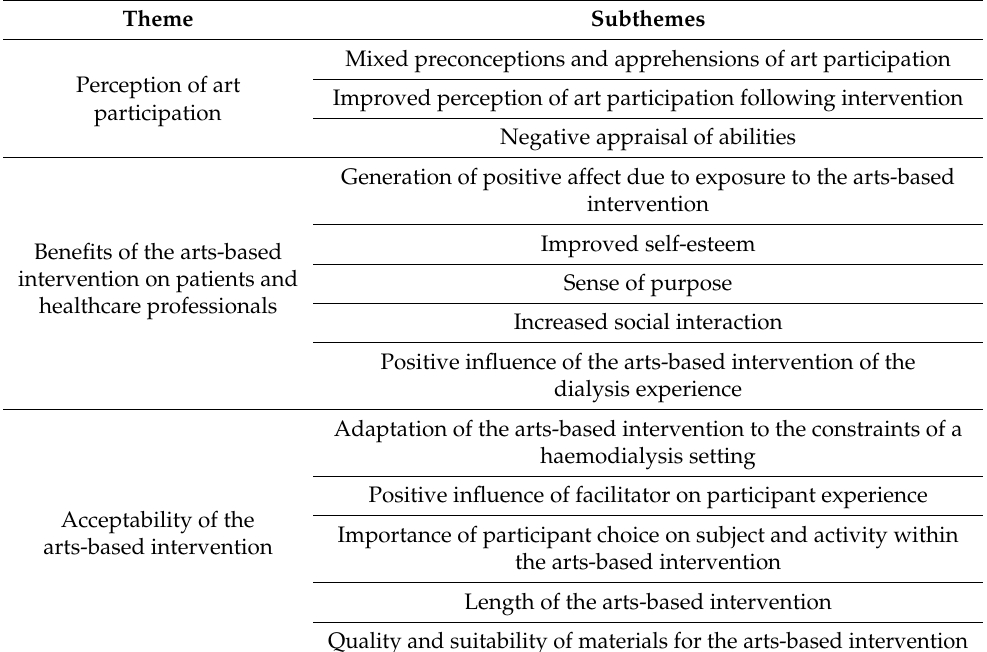
Table 1. Process evaluation themes and